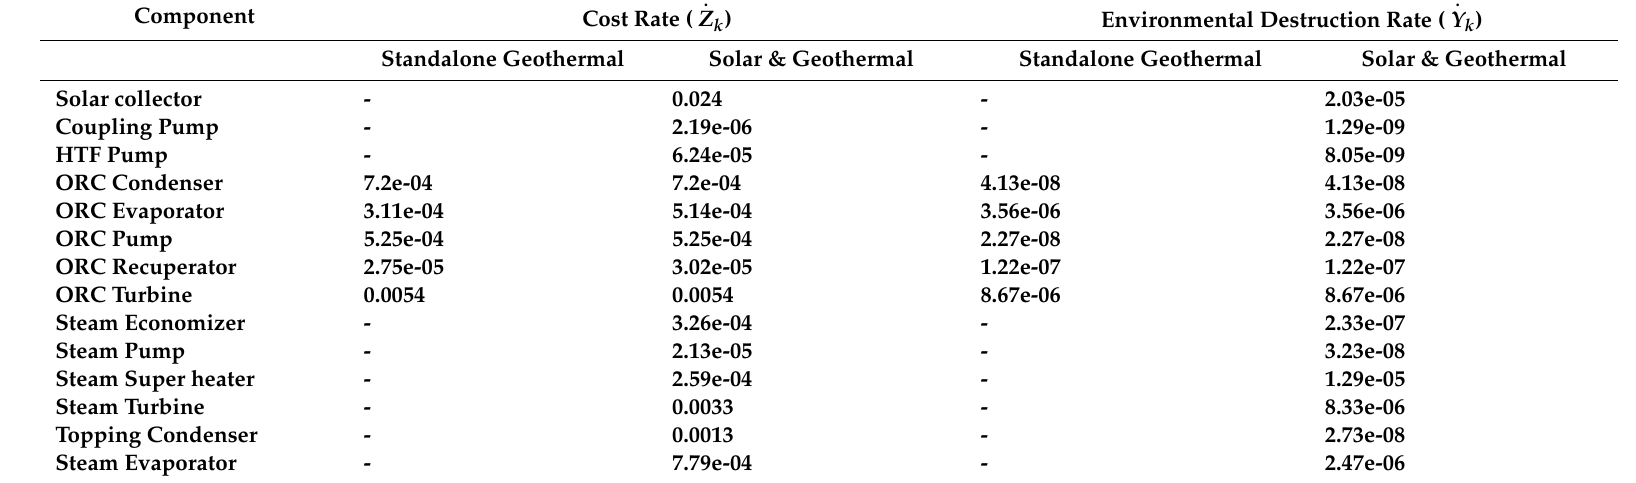
Table A1. Calculations for Cost rate and environmental destruction rate in the two operating cycle